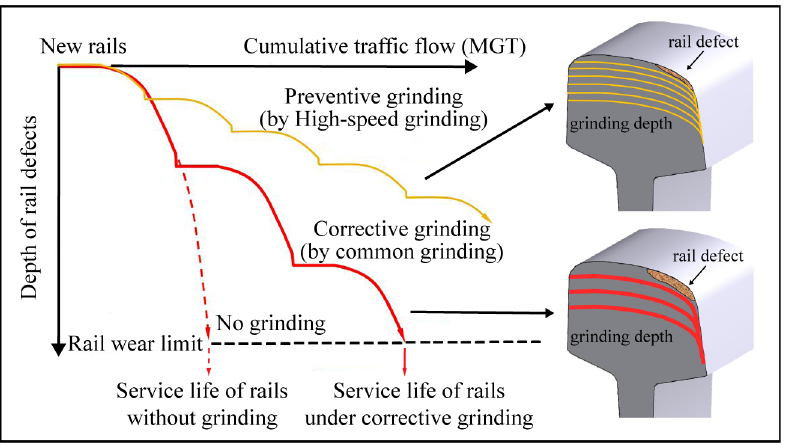
Figure 1. Effect of different grinding technologies on the service life of rails [17,21].